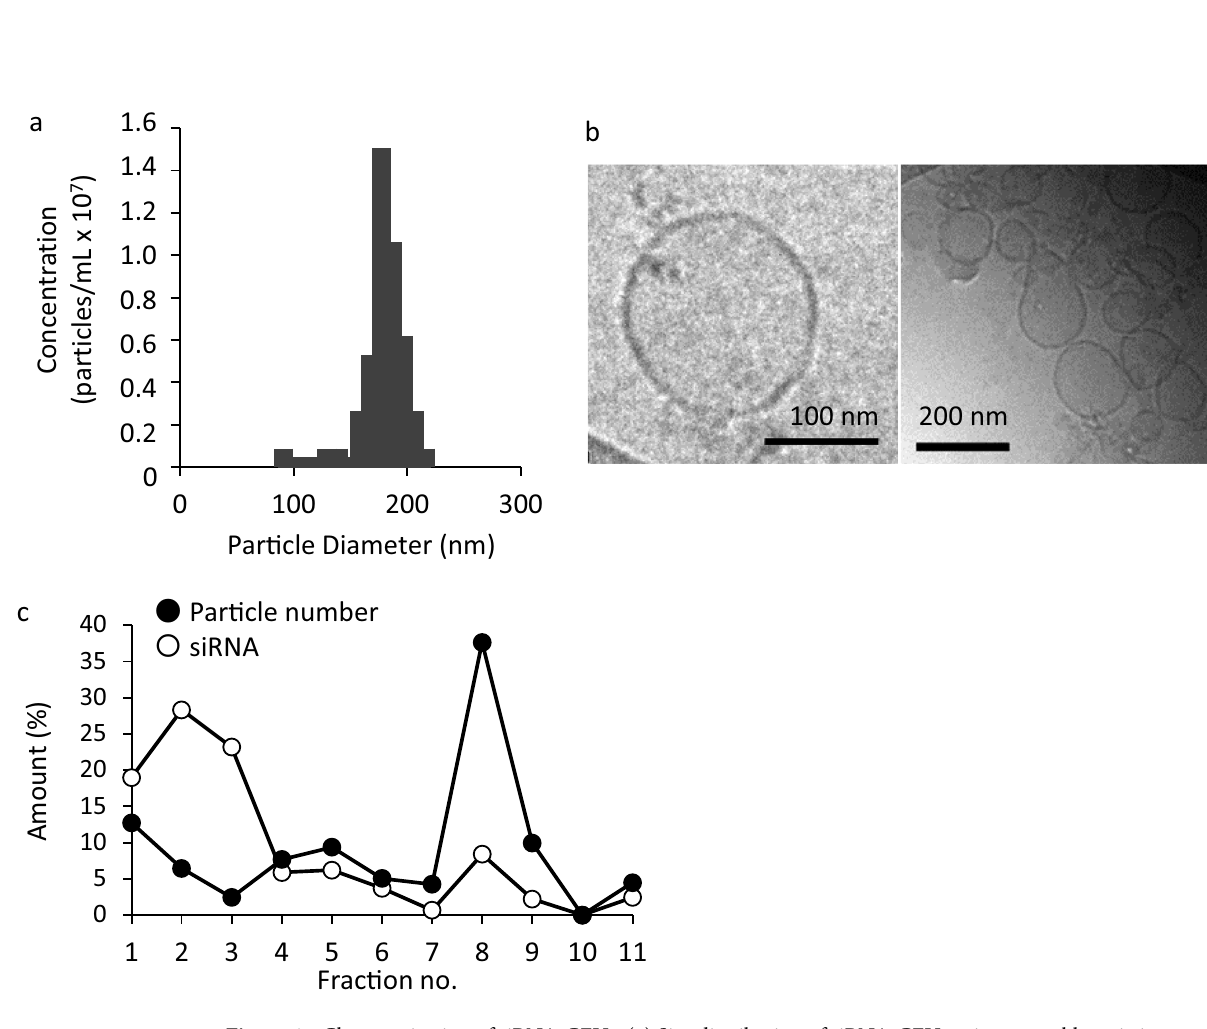
Figure 4. Characterization of siRNA-GEVs. ( a ) Size distribution of siRNA-GEVs using a tunable resistive pulse-sensing (TRPS) technique. ( b ) Cryogenic transmission electron microscopy (cryo-TEM) images of siRNA-GEVs. ( c ) The siRNA-GEVs prepared using a microfluidic device were fractionated by sucrose density gradient centrifugation. TAMRA-labeled siRNAs were analyzed using a fluorescence spectrophotometer, and particle numbers were calculated using